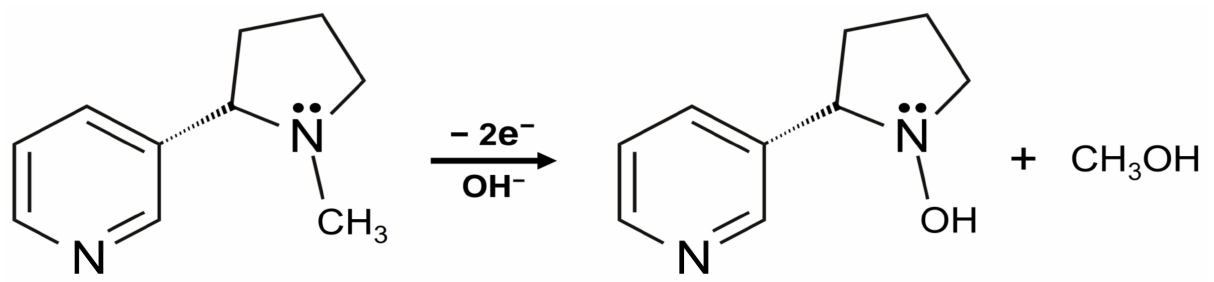
Figure 8. Schematic representation of oxidation mechanism of the